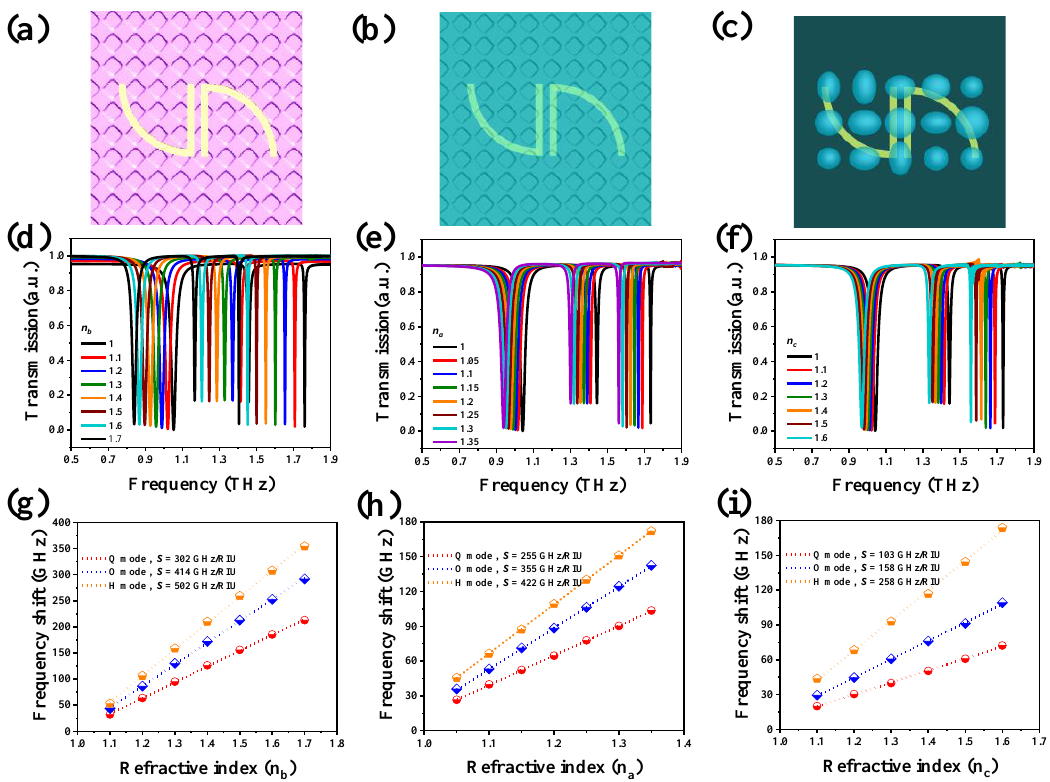
Figure 8. Schematics of top views of SSM ( a ) on a rough polydimethylsiloxane (PDMS) substrate, ( b ) covered with a crude analyte thin-film and ( c ) covered with random ellipse particles. ( d – f ) Transmission spectra of SSM ( d ) on rough PDMS substrate with different n b values, ( e ) covered with different crude analyte thin-films and ( f ) covered with different random ellipse particles. ( g – i ) The summaries of the relationships between the frequency shifts and refraction indexes of ( d – f ).